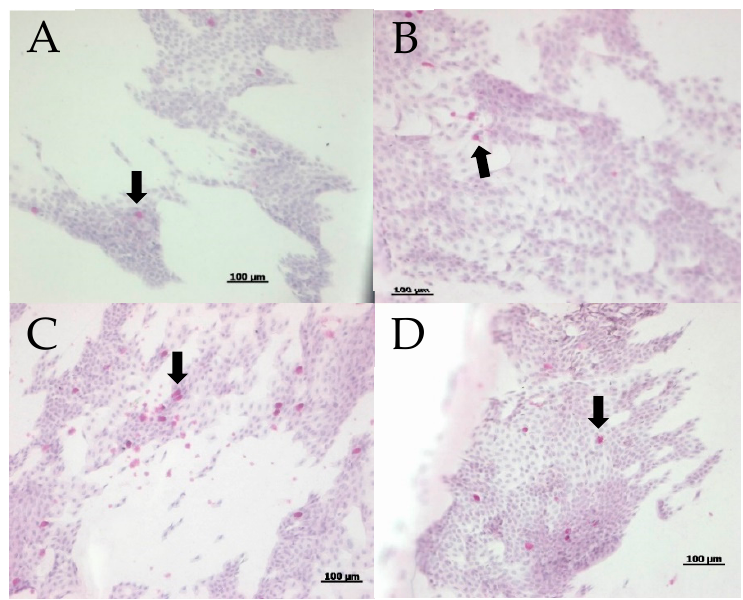
Figure 6. Representative MUC5AC PAS staining. Note the numerous MUC5AC + goblet cells before and after 1 month of eyewash (black arrows): ( A ) baseline in group one; ( B ) after 1 month in group one; ( C ) baseline in group two; and ( D ) after 1 month in group two.